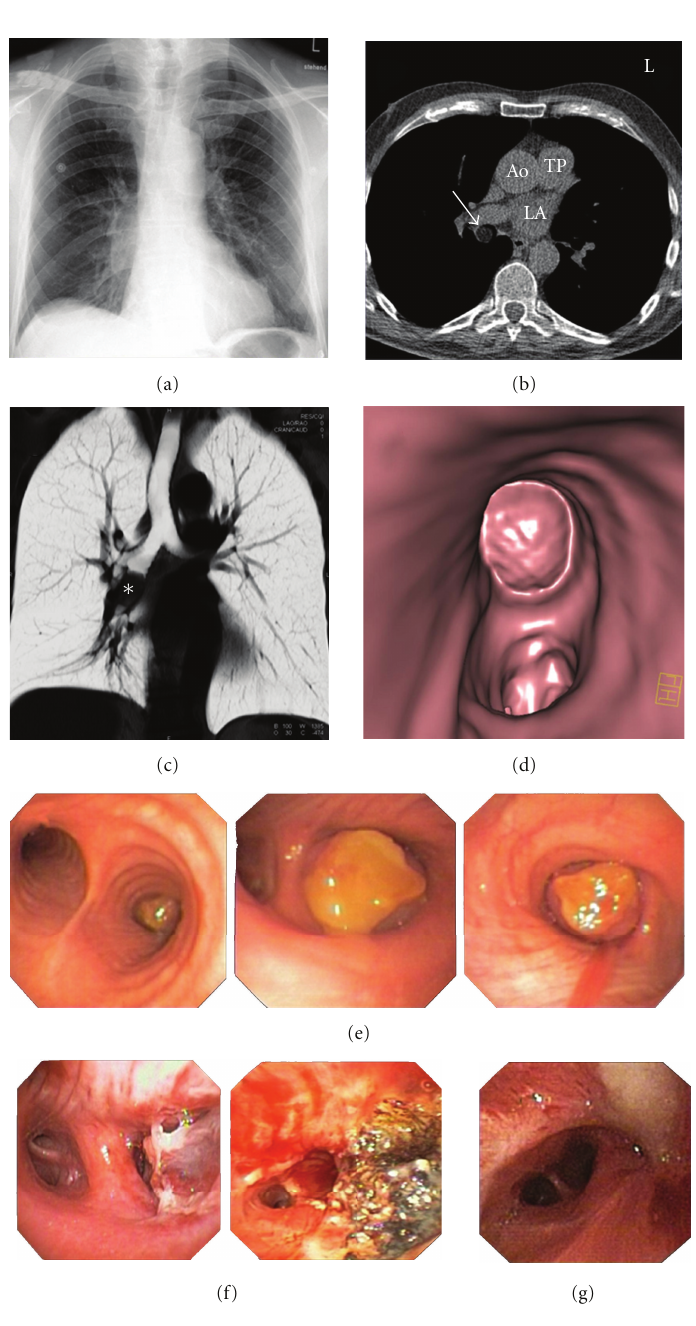
Figure 1: (a) On p.a. chest X-ray a prominent right hilum and a subtle increase in parenchymal density in the right infrahilar region was noted, a mass could not be clearly identified, however. (b) A noncontrast-enhanced CT scan of the chest revealed a mass within the bronchus intermedius (arrow) consisting mostly of fat with minimal inclusions of soft tissue density (Ao: Aorta ascendens; PT: pulmonary trunk; LA: left atrium). (c) Coronal slide in inverted thin-volume-rendering-technique of a contrast-enhanced CT scan performed for further workup demonstrated position and extent of the mass within the bronchus intermedius. (d) Virtual-bronchoscopy reconstruction from the nonenhanced CT scan displayed the mass within the proximal bronchus intermedius. The adjacent upper lobe bronchus was not a ff ected. (e) Endobronchial round tumorous obstruction of the intermediate bronchus with a smooth surface with subtotal obstruction of the intermediate bronchus. (f) Recurent subtotal exclusion of the intermediate bronchus in the course of the disease and repetition of Argon laser therapy. (g) Incipient focal metaplasia of respiratory mucosa into squamous